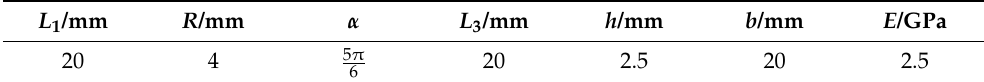
Table 1. Geometrical parameters and mechanical parameters.